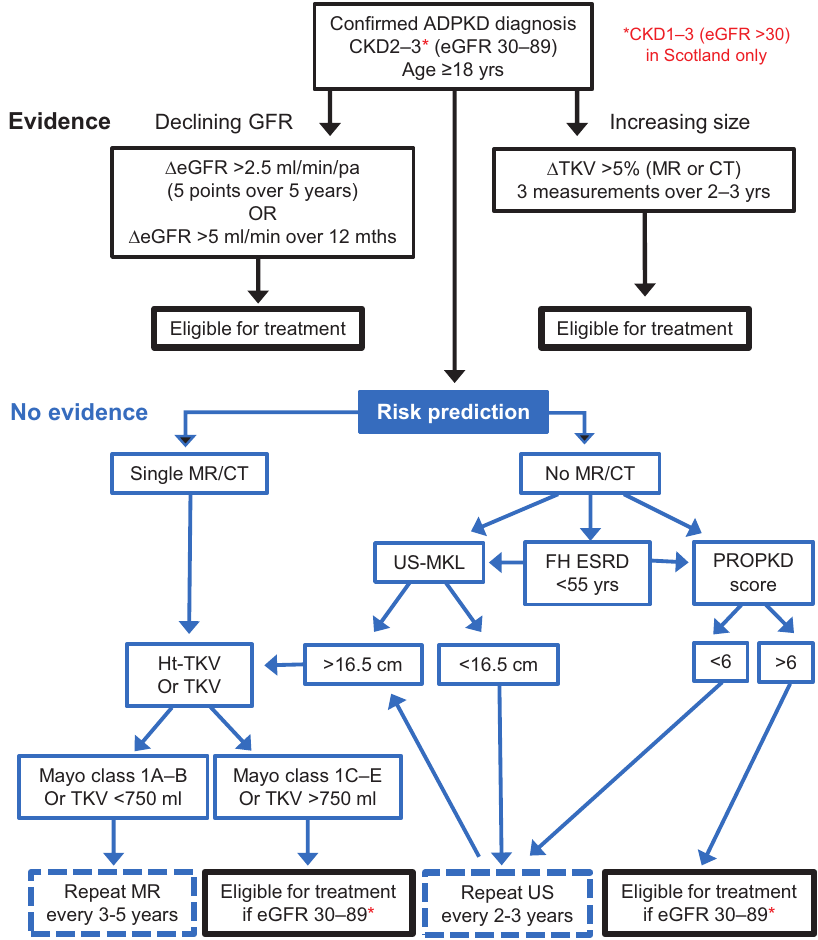
Figure 3. Recommended decision pathway for UK patients considered for treatment with tolvaptan according to Renal Association guidance based on the NICE decision. NICE has recommended that autosomal dominant polycystic kidney disease patients in England with chronic kidney disease stages 2 or 3 and evidence of rapidly progressive disease are eligible for treatment. This decision differs from that made by the Scottish Medicines Consortium and the European Medicines Agency in excluding patients with chronic kidney disease stage 1. Evidence of rapid disease progression has been defined as a significant decline in estimated glomerular filtration rate or increase in total kidney volume or both. In the absence of such evidence, risk prediction algorithms based on total kidney volume (Mayo Classification) or genotype (PROPKD) are the best predictors of prognosis. NICE, National Institute for Health and Clinical